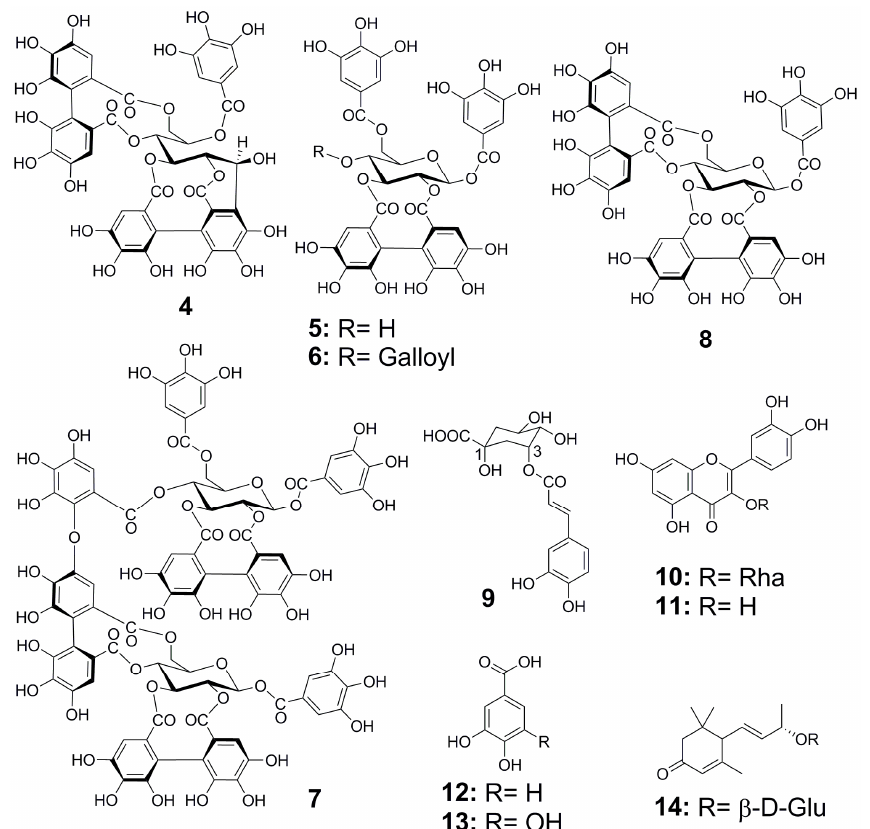
Figure 5. Compounds isolated from Meriania hernandoi and Meriania nobilis leaves.